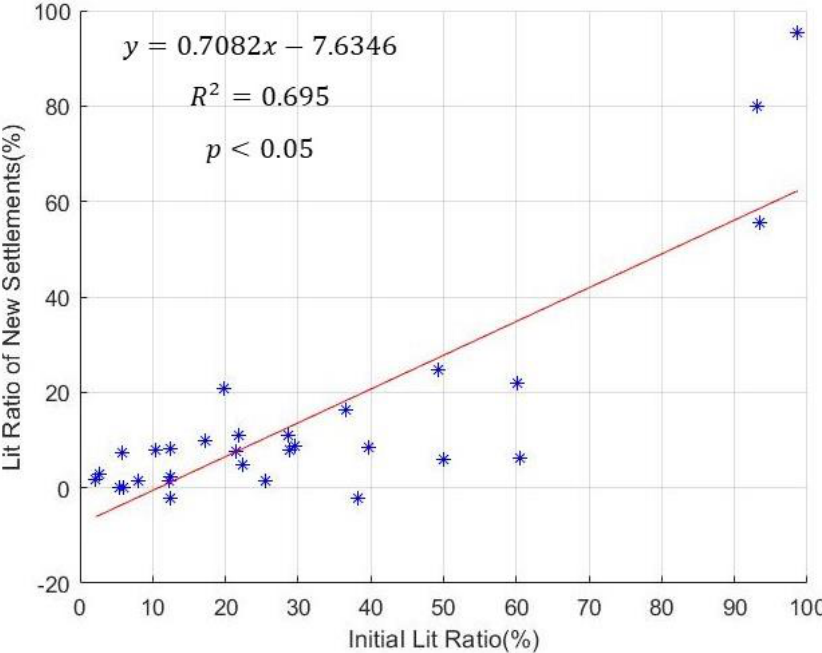
Figure 13. The scatter diagram and the linear fitting curve showing the relationship between the initial lit ratio and the lit ratio of the new settlements in 30 districts of Rwanda. In the figure, y denotes the lit ratio of new settlements, and x denotes the initial lit ratio. The R 2 of the linear regression is 0.695 ( p < 0.05).